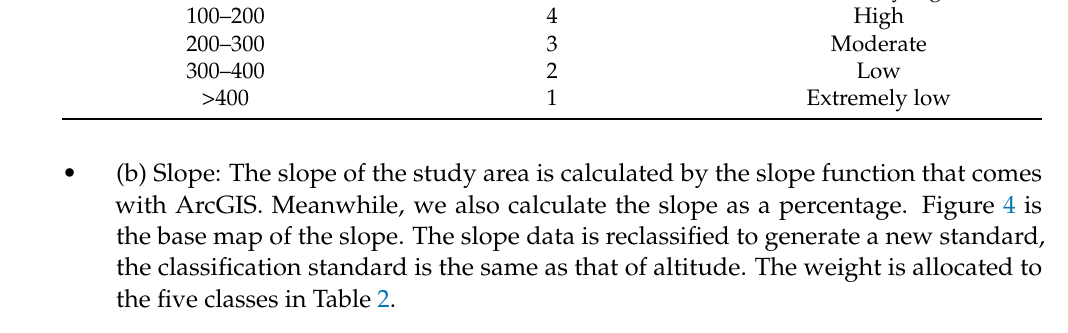
Table 2. Fire risk classification of